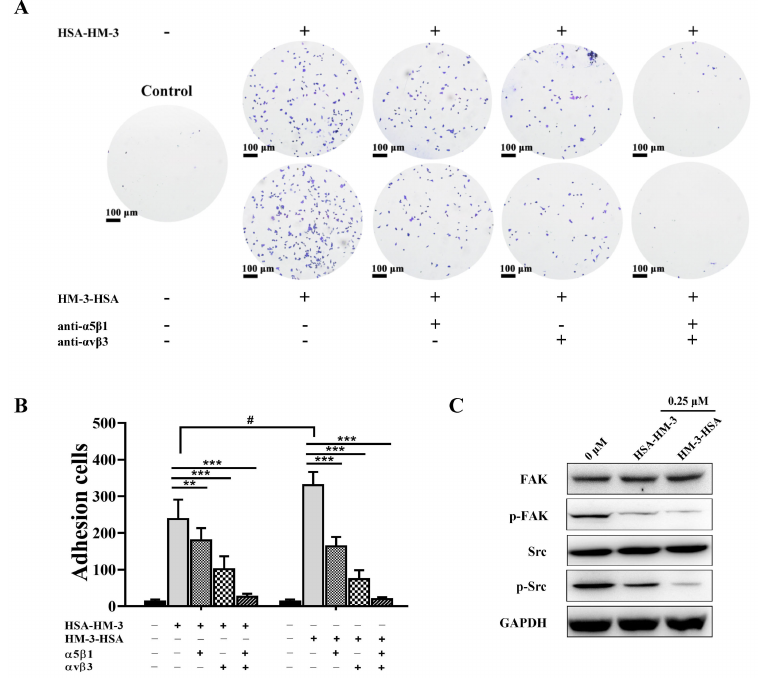
Figure 7. HM-3/HSA inhibited FAK/Src signaling pathways by binding with integrin α v β 3 and α 5 β 1. ( A , B ) The integrin monoclonal antibody-blocking assay was performed to verify the interaction between HM-3/HSA and both integrin α 5 β 1 and α v β 3. The high binding rate of HM-3/HSA increased with B16F10 cells through binding with integrin α v β 3 and α 5 β 1 of the cell surface, but the adhesion number was significantly decreased when B16F10 cells were blocked with the integrin α v β 3 or α 5 β 1 antibody. Control: cells treated with the PBS vehicle only. Scale bar = 100 µ m. Data shown are means ± standard deviation from three independent experiments. ** p < 0.01, *** p < 0.001, and # p < 0.05. ( C ) HM-3-HSA affected the FAK/Src signaling pathway in B16F10 cells. The B16F10 cells were treated with 0.25 µ M HSA-HM-3 or 0.25 µ M HM-3-HSA for 48 h. GAPDH was used as the internal reference. Data shown are means ± standard deviation from two independent